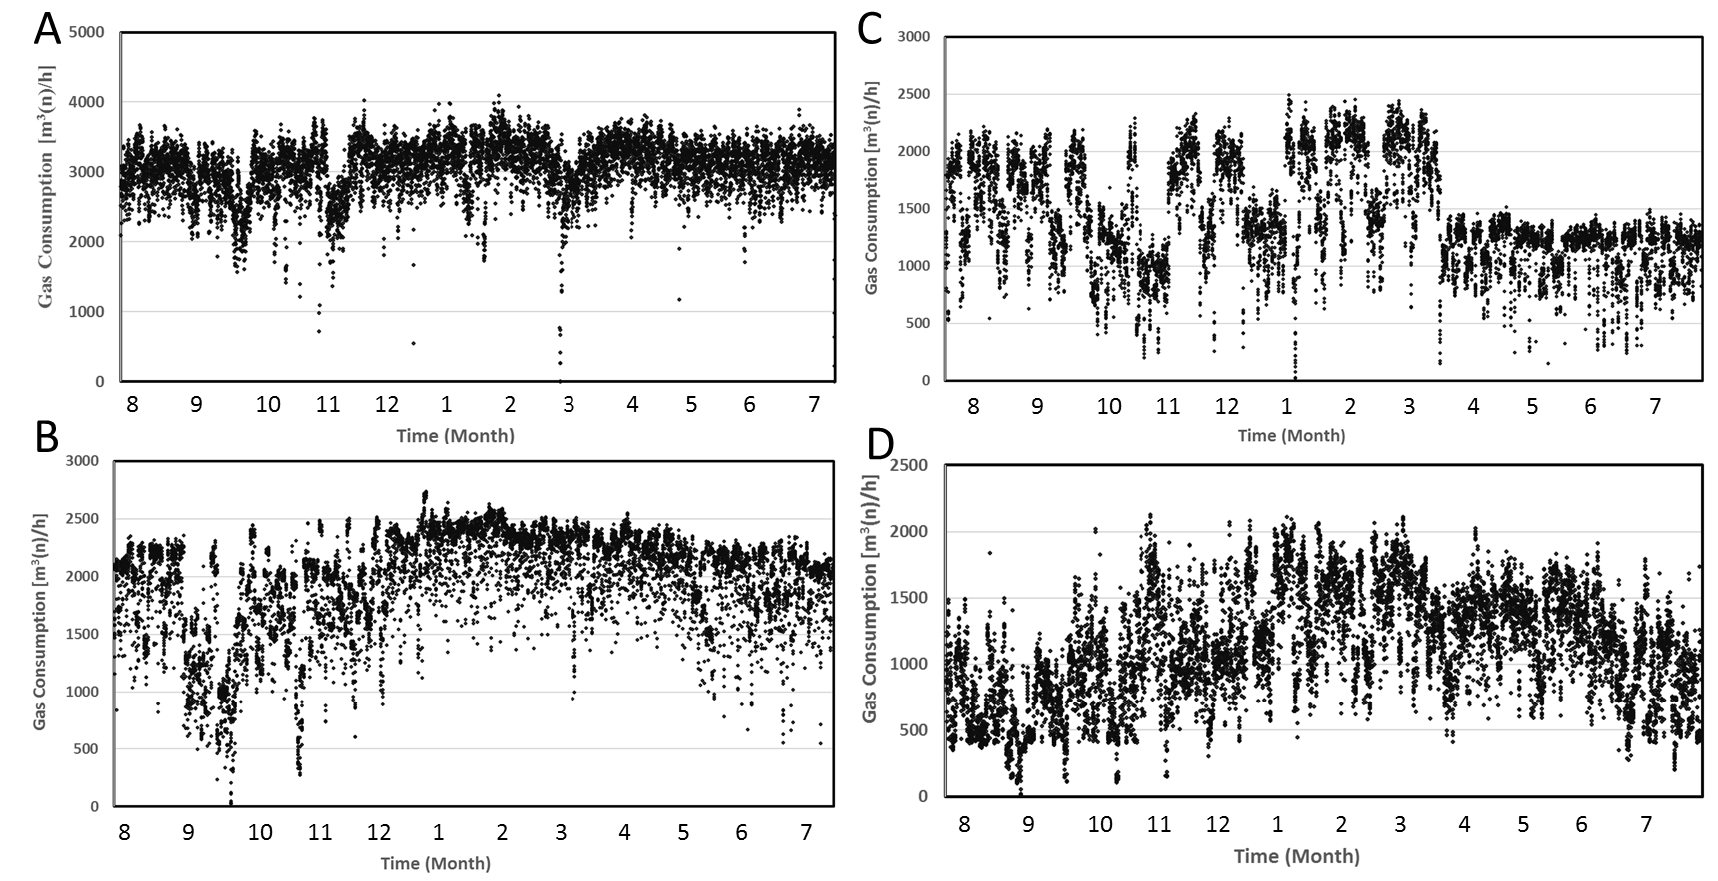
Figure 5. Hourly gas consumption data for the period of one year where ( A – D ) denote the four different food industries, and X-axis denotes the 12 months starting from August to July.